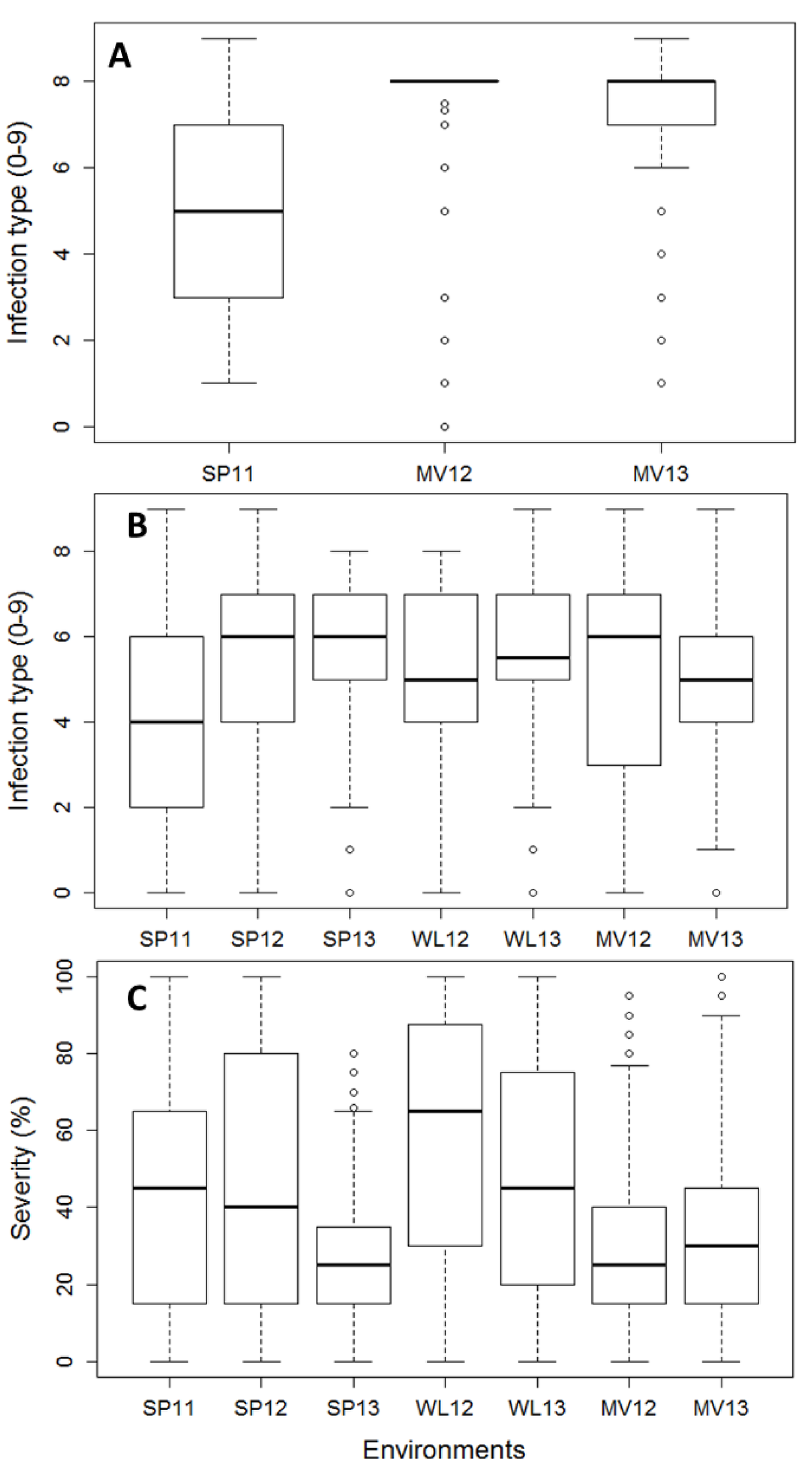
Fig 3. Boxplot representing the phenotypic distribution for seedling infection type (IT)(A), adult IT (B), and adult disease severity (SEV)(C).